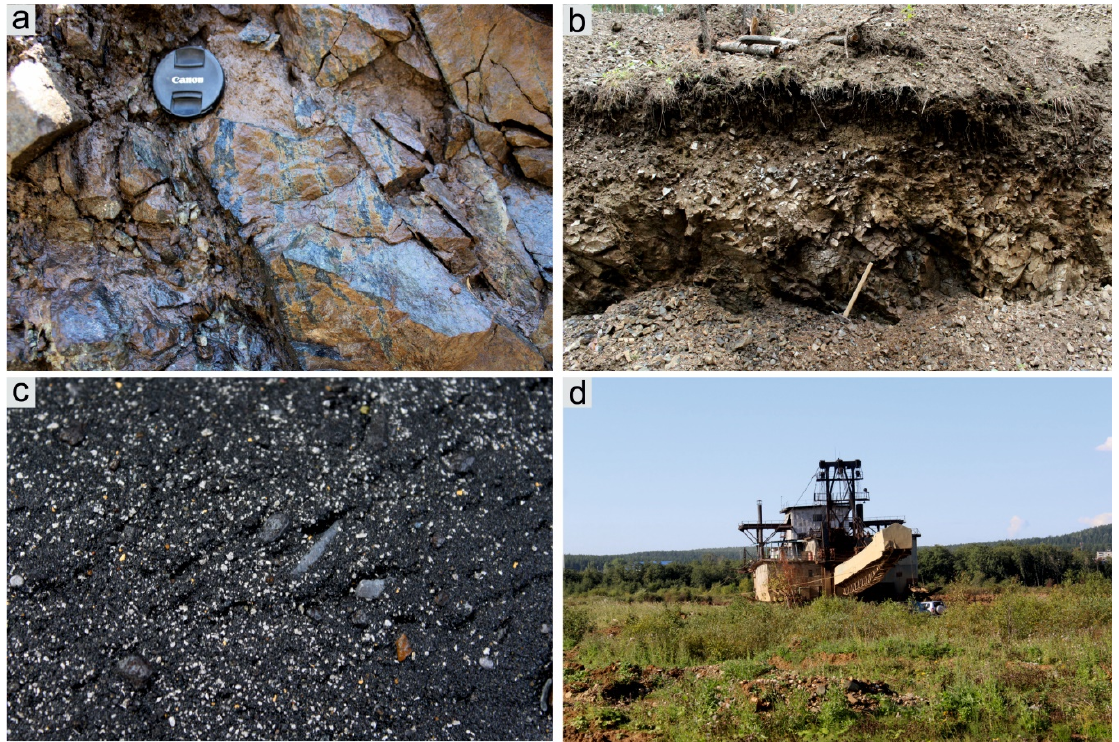
Figure 3. ( a ) Photo of chromitite in bedrock of Svetloborsky massif, ( b ) dunite gutter with modern sediments at proximal placer, ( c ) heavy mineral concentrate with PGM, and ( d ) the last dredge at the Isovsko-Turinskaya placer system.